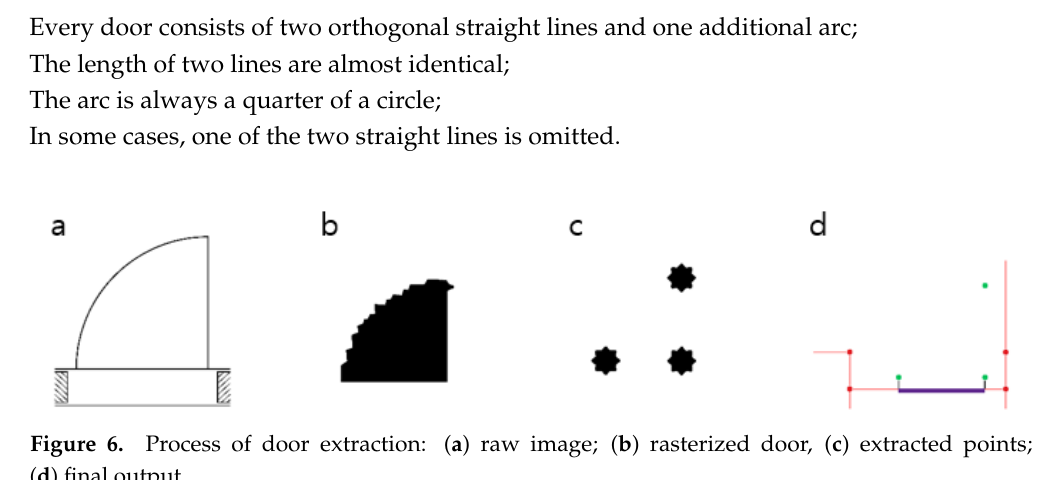
Figure 5. Restoring wall thickness using the moving kernel method.